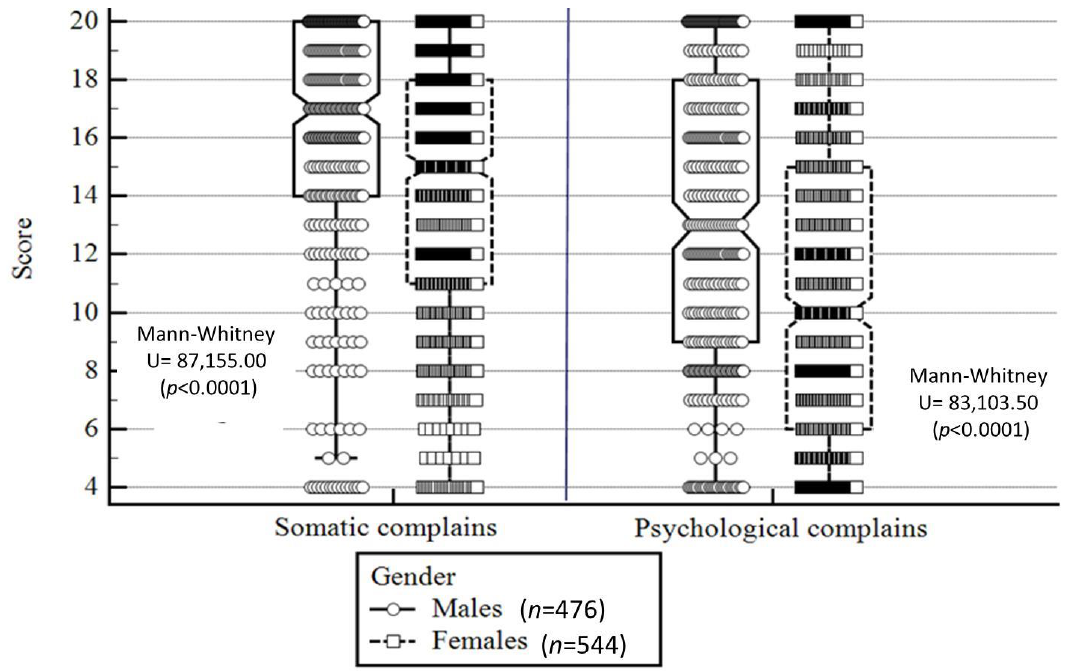
Figure 1. Somatic and psychological symptoms—gender differences. Notes: Higher score represents fewer somatic and psychological symptoms; the central box represents the values from the lower to upper quartile (25–75 percentiles); the vertical line extends from the minimum to the maximum value, excluding outside values which are displayed as separate points. An outside value is defined as a value that is smaller than the lower quartile minus 1.5 times the interquartile range, or larger than the upper quartile plus 1.5 times the interquartile range; the middle line represents the median. Participants’ remote learning